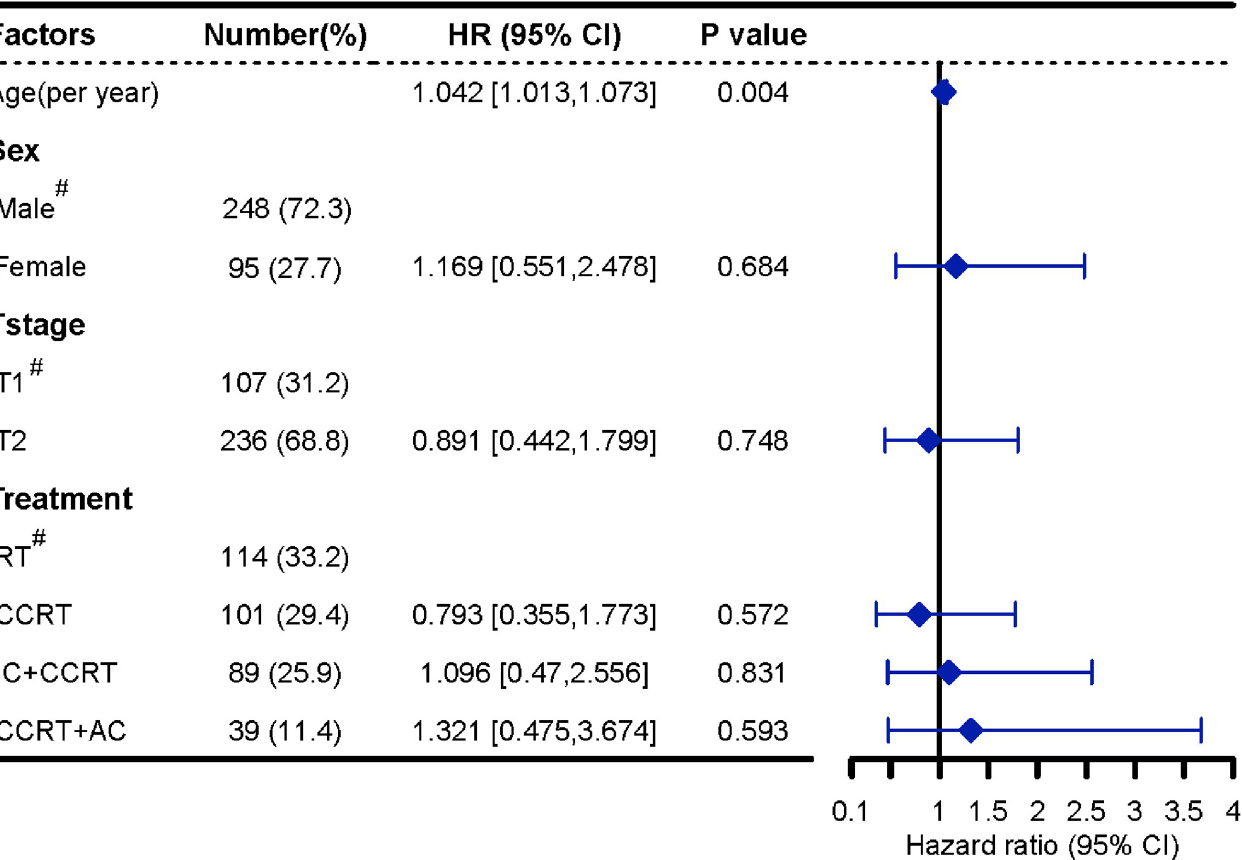
Fig 3. Cox Forest plots for the death of patients with T 1-2 N 1 M 0 NPC. HRs and P values are calculated with the adjusted Cox proportional hazards model. HR = hazard ratio, CI = confidence interval, RT = radiotherapy, CCRT = concurrent chemoradiotherapy, IC = induction chemotherapy, AC = adjuvant chemotherapy. # = reference